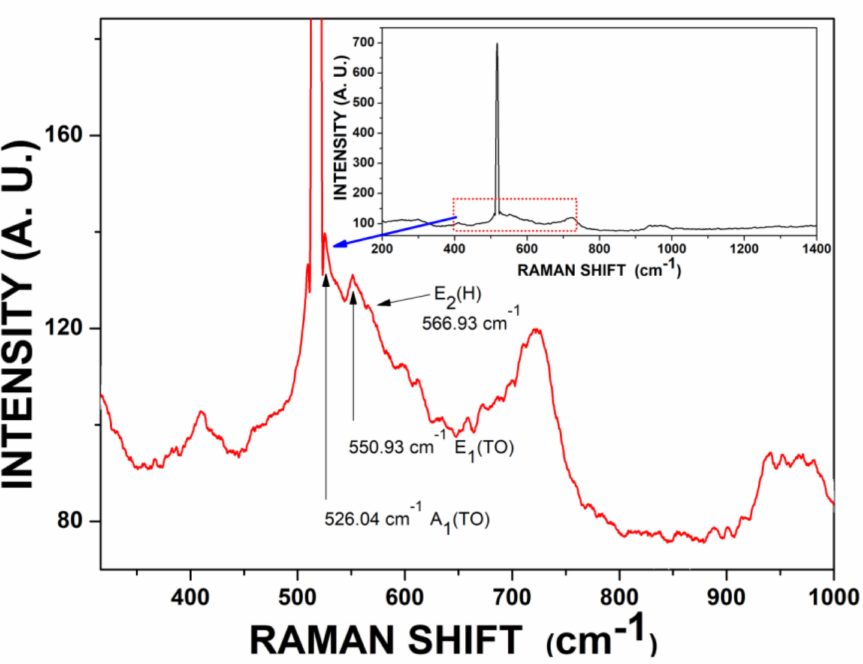
Figure 10. Raman scattering of the Zn-doped GaN films deposited by radio-frequency magnetron